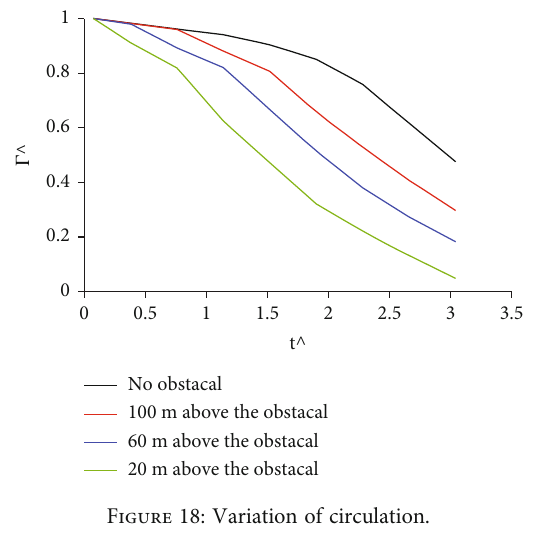
Figure 20: Variation of wake vortex core